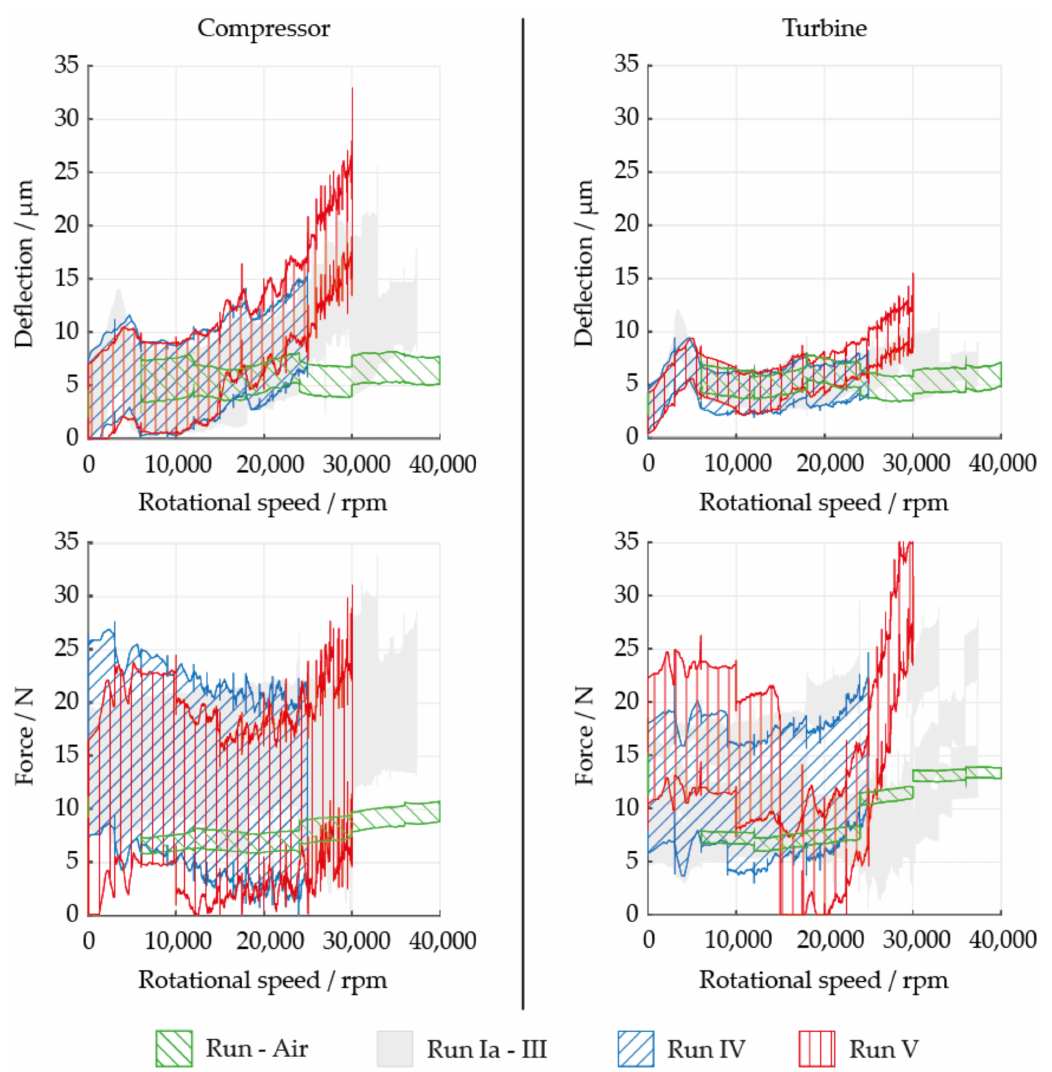
Figure 10. Deflections and forces depicted as function of speed for region IV and V in Figure 6 compared to previous test runs: ( top ) deflections; ( bottom ) forces; ( left ) at compressor bearing; ( right ) at turbine